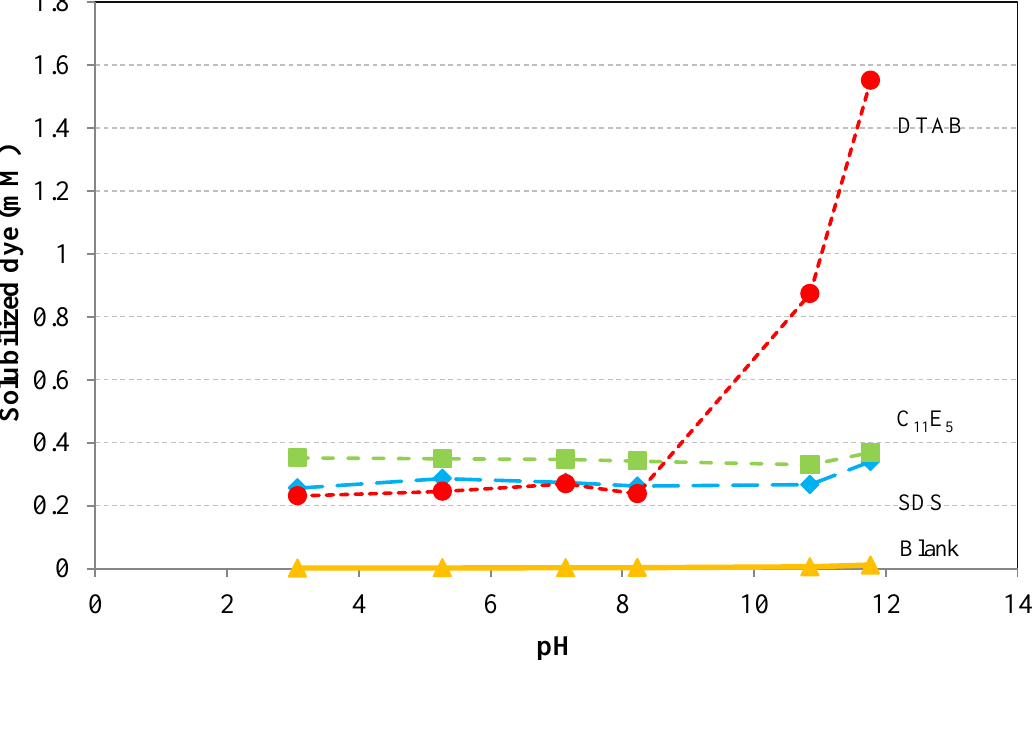
Figure 13. Effect of pH on solubilization of C.I. Solvent Yellow 14 (Sudan I) at 21  C for dodecyltrimethylammonium bromide (DTAB), sodium dodecyl sulfate (SDS), and penta(ethylene glycol)monoundecyl ether (C